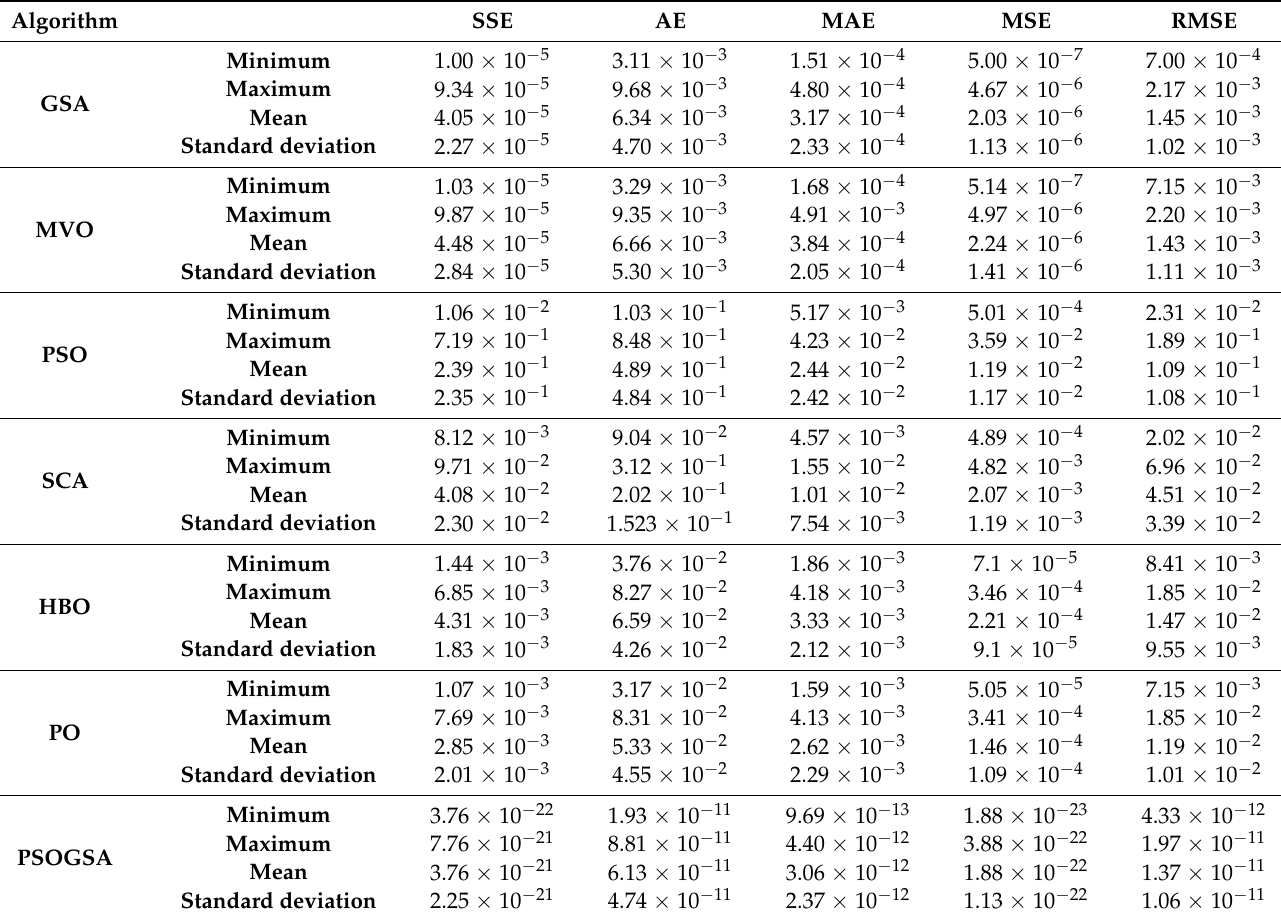
Table 9. The MTDM calculation error, mean and standard deviation for the monocrystalline PV Cell.